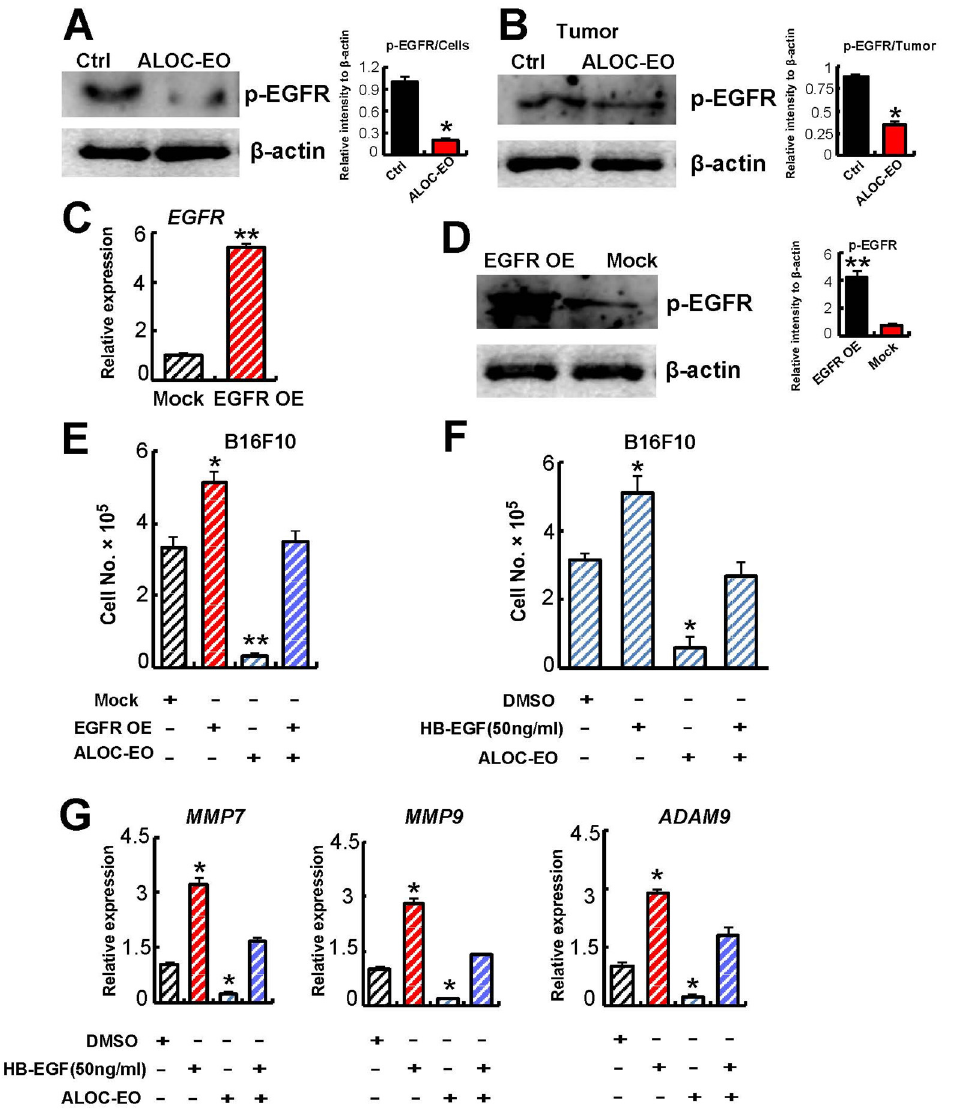
Figure 3. ALOC-EO targets EGFR and ERK1/2. ( A ) Immunoblot for phosphorylated murine EGFR in B16F10 cells treated with either DMSO or ALOC-EO after 12 h. Right panel: The histogram represents the signal intensity of the indicated protein bands in arbitrary units after normalization with the signal intensity of β -actin internal control for each sample. Values are means and SEM of two independent experiments. ( B ) Representative immunoblot for phosphorylated murine EGFR and loading control β -actin in tumor cell lysates from control and ALOC-EO-treated mice. Right panel: The histogram represents the signal intensity of the indicated protein bands in arbitrary units after normalization with the signal intensity of β -actin internal control for each sample. Values are means and SEM of two independent experiments. ( C ) EGFR overexpression (EGFR OE) was confirmed in B16F10 cells and mock controls by qPCR, and the fold change in EGFR expression compared to expression of β -actin is given (n = 3). ( D ) EGFR phosphorylation was performed in cell lysates of EGFR OE and mock cells by Western blotting. Right panel: The histogram represents the signal intensity of the indicated protein bands in arbitrary units after normalization with the signal intensity of β -actin internal control for each sample. Values are means and SEM of two independent experiments. ( E ) EGFR OE and mock cells were treated with/without ALOC-EO. Cells were counted after 24 h in culture (n = 6/group). ( F ) B16F10 cells were treated with/without rec. HB-EGF in the presence or absence of ALOC-OC. Cells were counted 24 h later (n = 6/group). ( G ) Murine MMP7 , MMP9 , ADAM9 , and HB-EGF expression in EGFR OE and mock B16F10 cells treated with or without HB-EGF in the presence or absence of ALOC-EO by qPCR. Transcript levels were normalized to β -actin. +/ − SEM. * p < 0.05; ** p < 0.01 (Student’s t